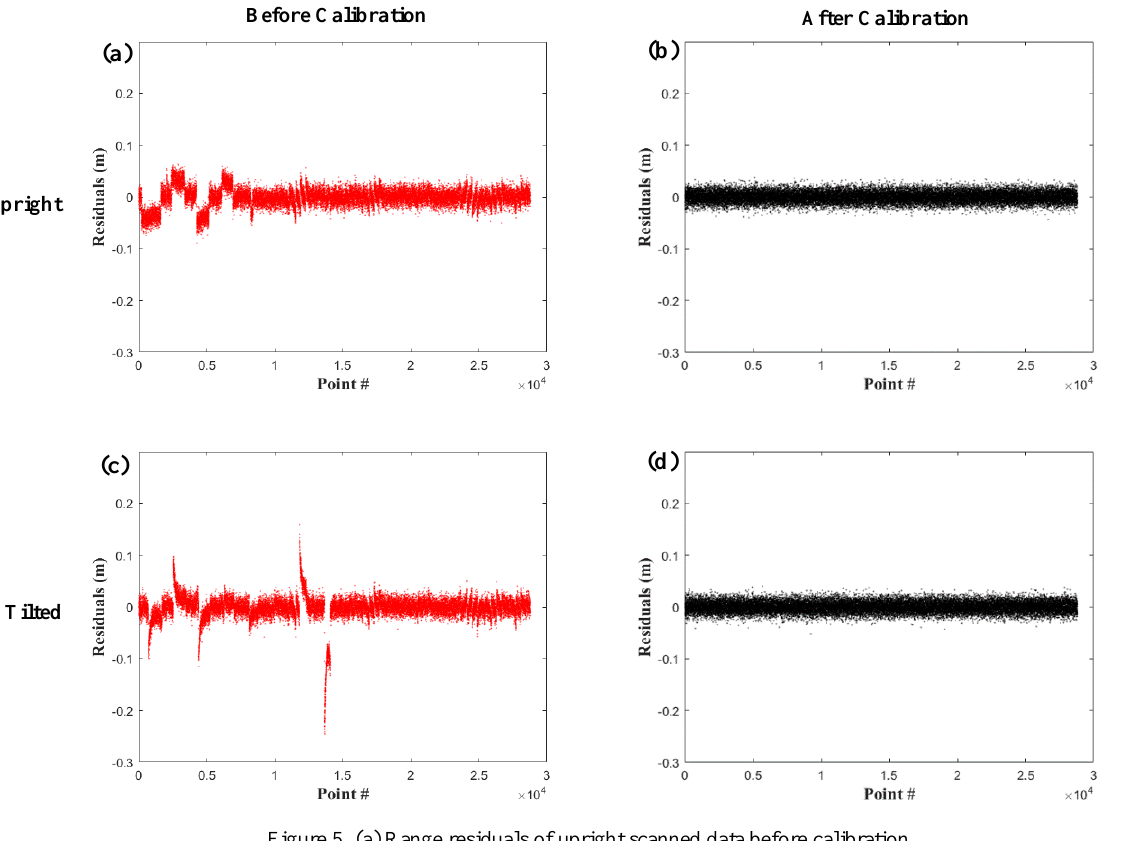
Figure 5. (a) Range residuals of upright scanned data before calibration